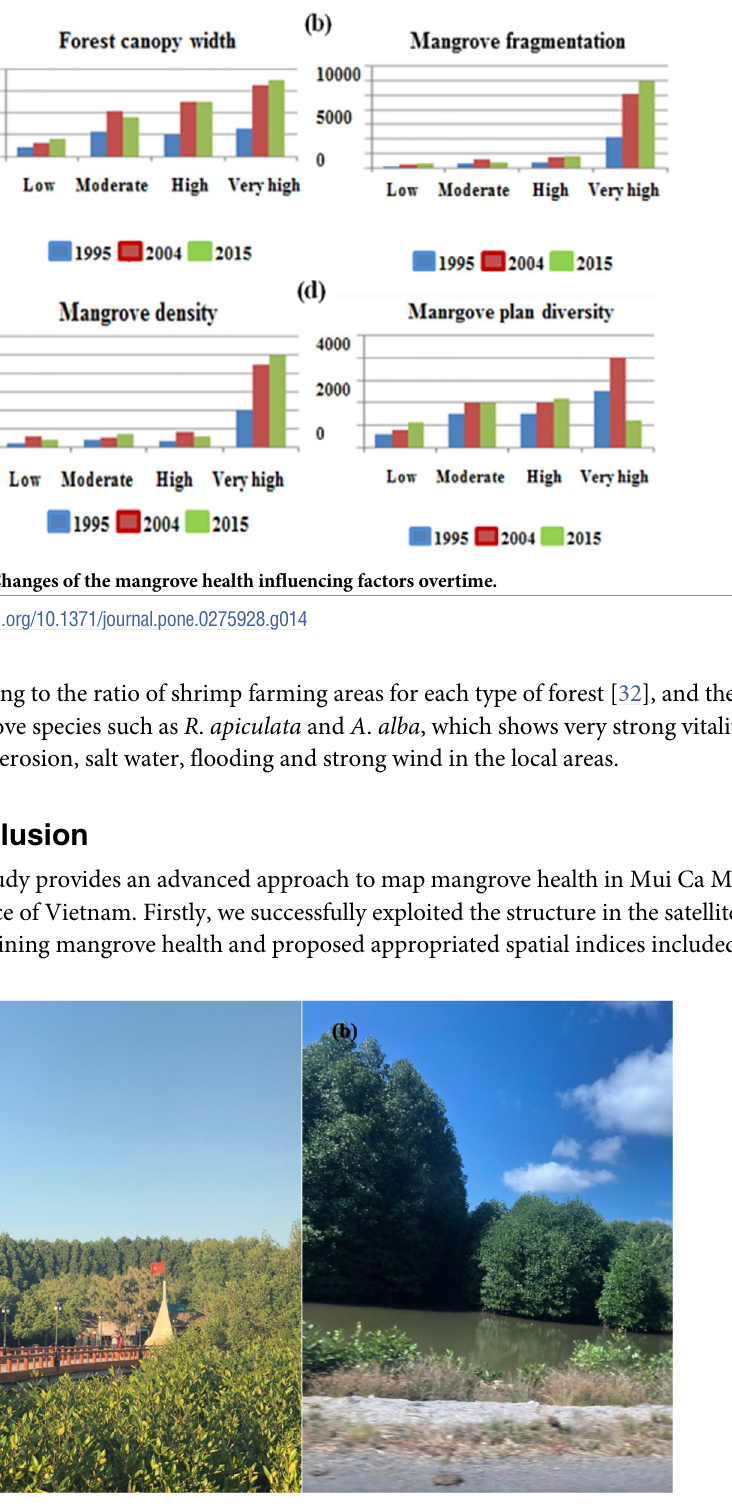
Fig 15. The bridge to the landmark at the end of the National 1 st highway (left side) and ecological forest shrimp farms (right side).